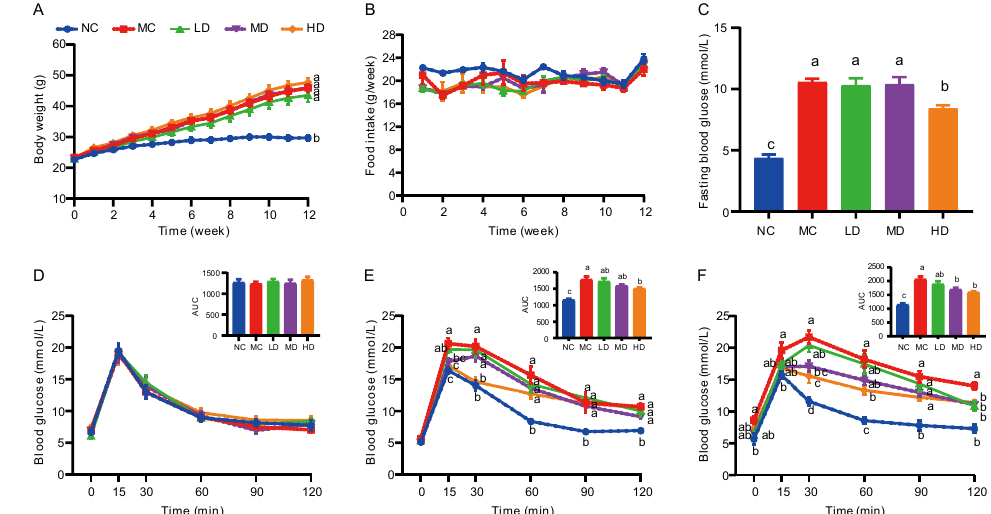
Figure 1. Effect of PHB on the bodyweight, food intake, and glucose metabolism in HFD mice. ( A ) Bodyweight. ( B ) Food intake. ( C ) Fasting blood glucose. ( D – F ) OGTT curve and AUC at week 0 ( D ), week 6 ( E ), and week 12 ( F ), respectively. Results are presented as mean ± SEM ( n = 8). Different letters are significantly different ( p < 0.05) based on Tukey multiple range test. PHB, partly milled highland barley; NC, normal control group; MC, model control group fed HFD; LD, low-dose group fed HFD containing 10% PHB; MD, middle-dose group fed HFD containing 20% PHB; and HD, high-dose group fed HFD containing 30% PHB.